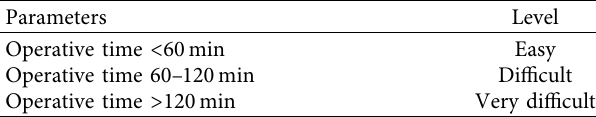
Table 3: Intraoperative assessment.